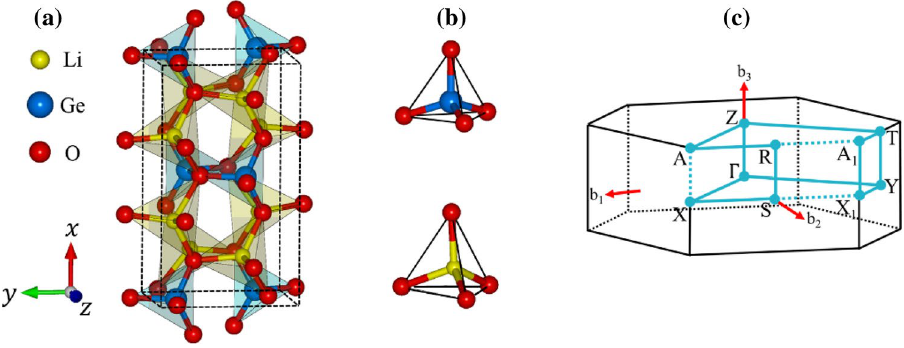
Figure 1. The optimal geometric structure of the Li 2 GeO 3 ternary compound, ( b ) oxygen atoms around each Li/Ge one, and ( c ) the first Brillouin zone.